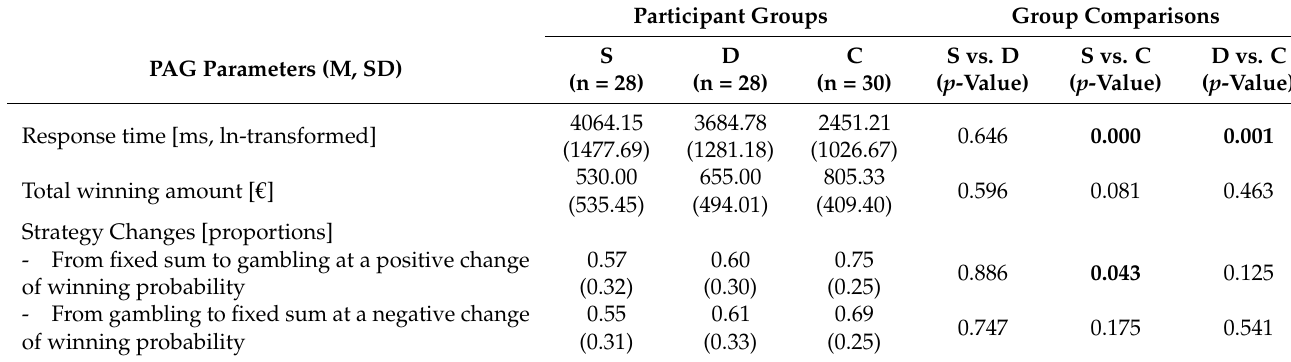
PAG = Probability-Associated Gambling Task; M = mean; SD = standard deviation; S = patients with schizophrenia; D = patients with major depression; C = healthy controls; bold values indicate significant group differences, p <